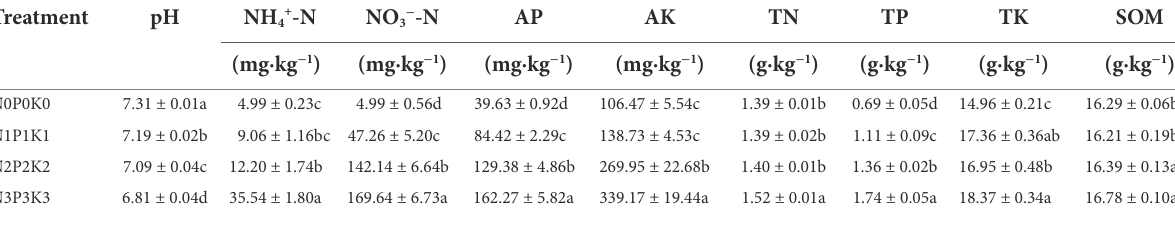
TABLE 2 The effects of different fertilization levels on soil chemical properties.